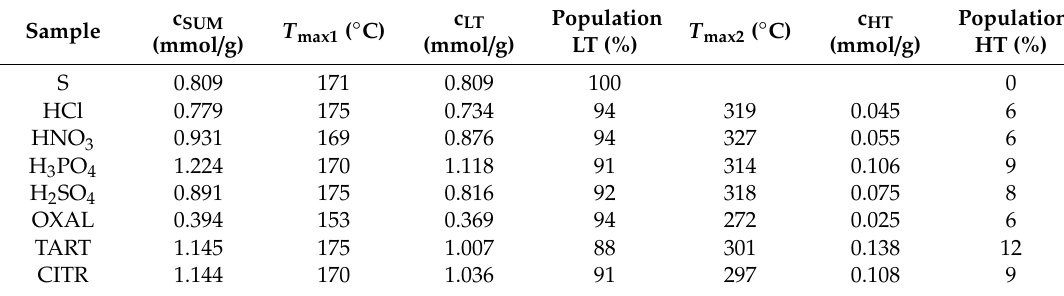
Table 5. Acidity of 1 M acids modified zeolite foam pellets determined by the NH 3 -TPD.